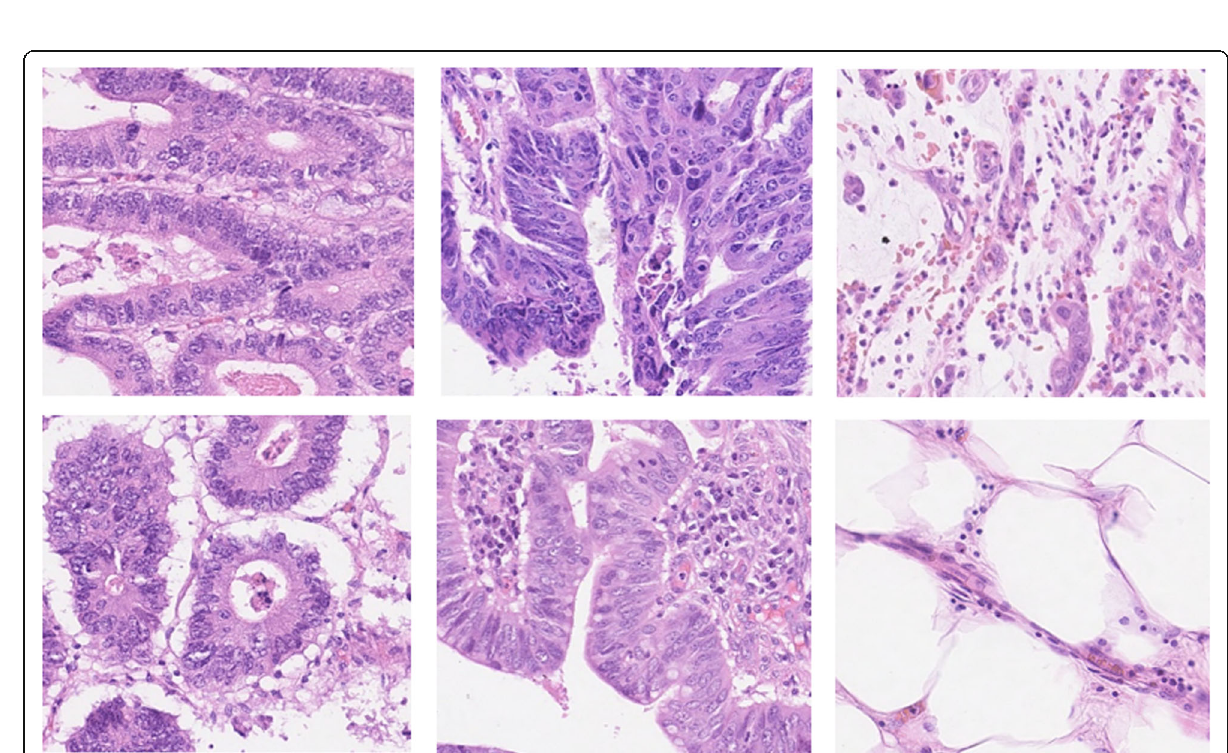
Fig. 6 Randomly selected example images from the nuclei classification dataset